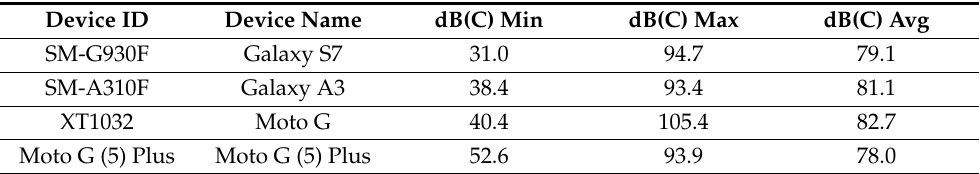
Table 7. Minimum, maximum, and average recorded environmental noise levels in the TYT database for the different device models used in the